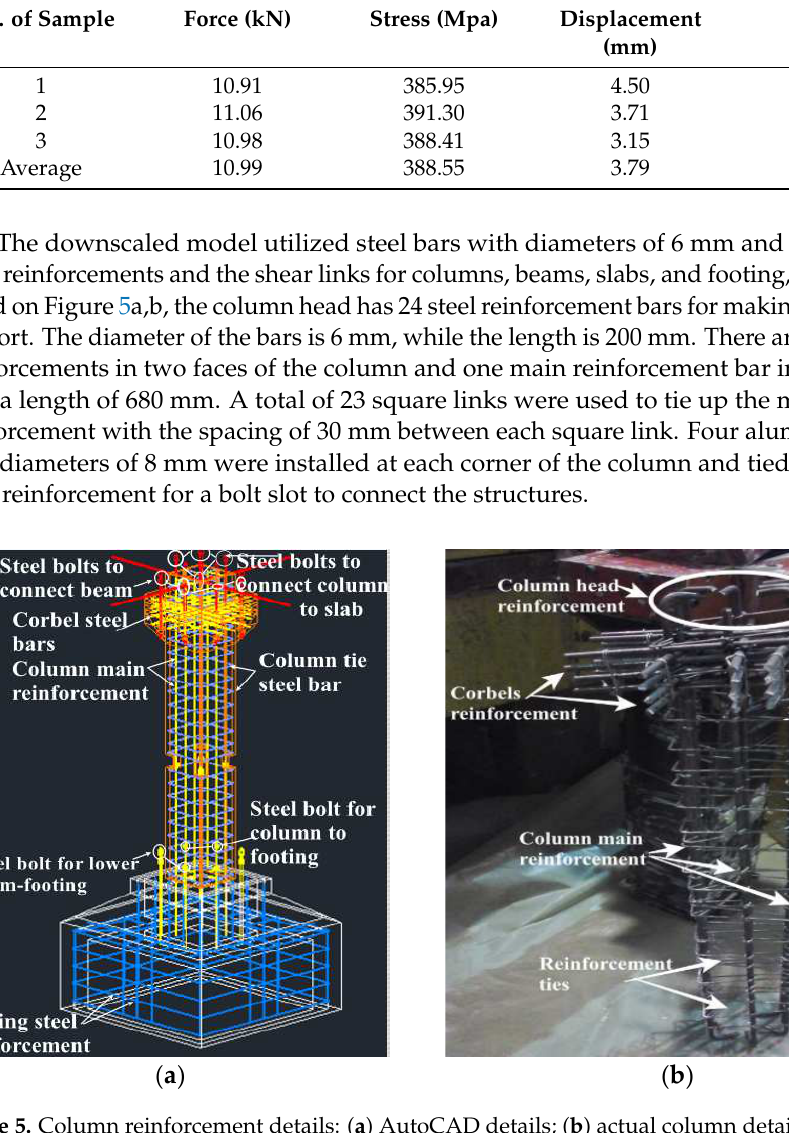
Table 8. Results for 6 mm-diameter steel bolts.